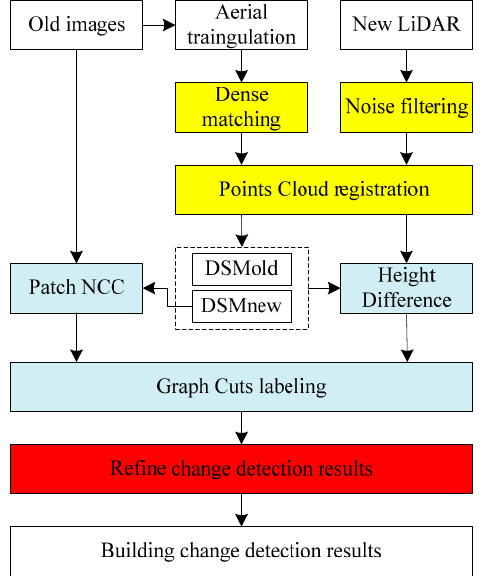
Figure 3. Framework of the building change detection method.